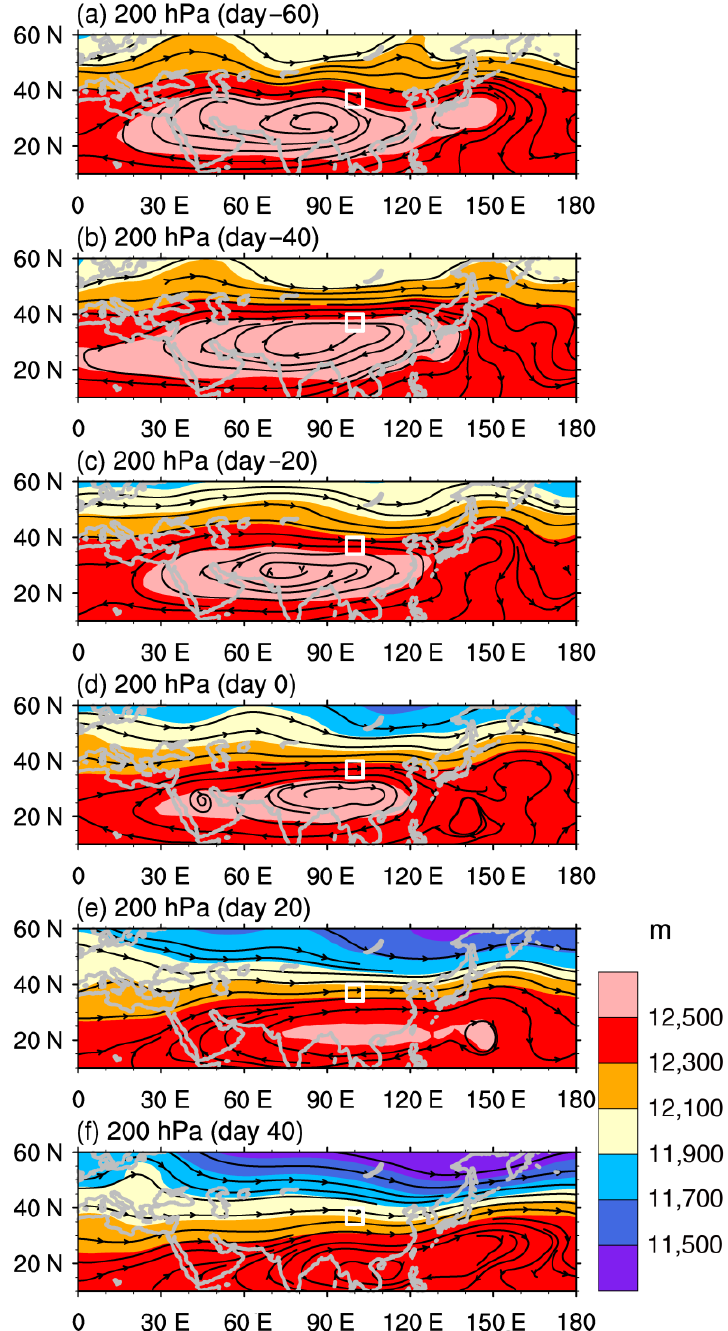
Figure 6. Composite analysis (2010–2015) of daily mean 200 hPa streamline field and geopotential height (shaded, m), from day − 60 to 40 relative to transition date with a 20-day interval, ( a ) day − 60, ( b ) day − 40 ( c ) day − 20, ( d ) day 0, ( e ) day 20, and day 40. The white boxes indicate the study region.